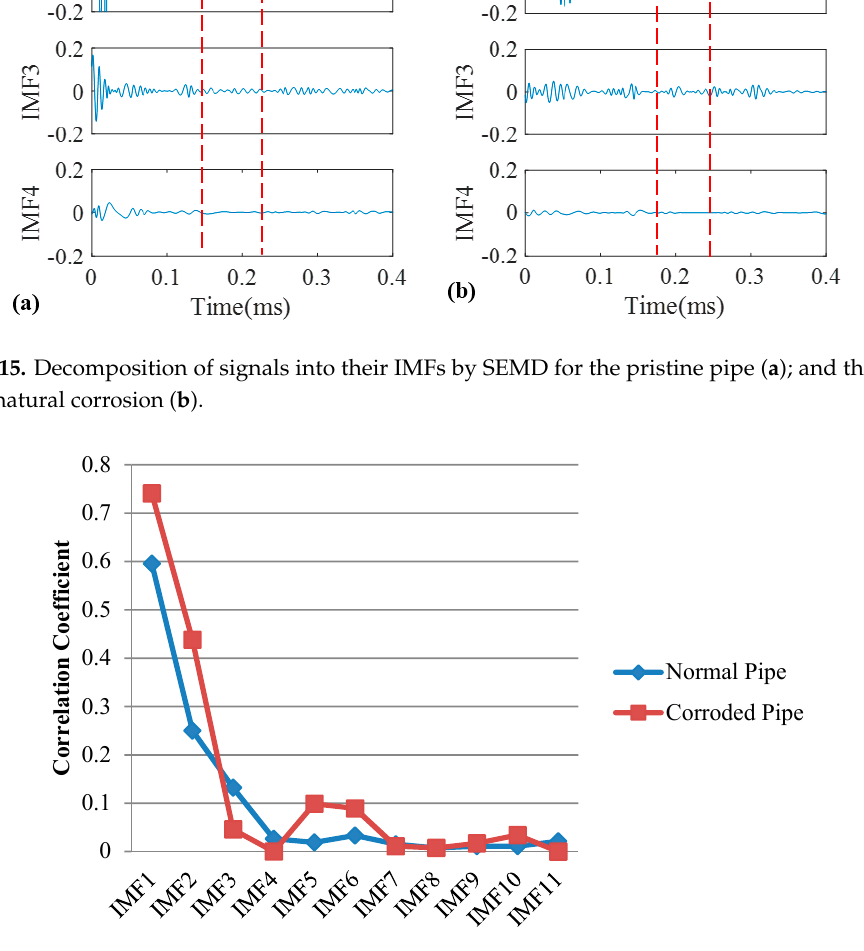
Figure 16. Absolute cross correlation of guided wave signals from pipes with their corresponding IMFs obtained from SEMD.